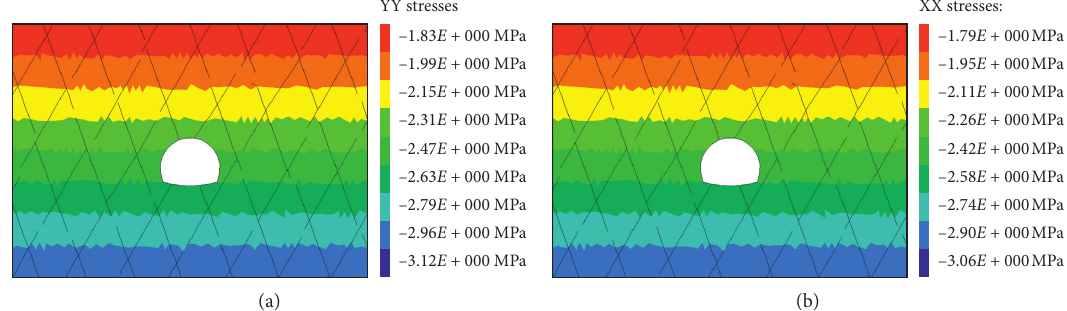
Figure 6: The initial geostress field. (a) The vertical geostress. (b) The horizontal geostress.